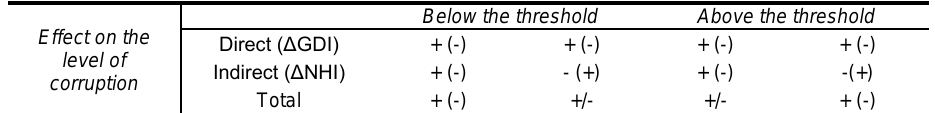
Table 1. Effects of the degree of proportionality of the electoral system on